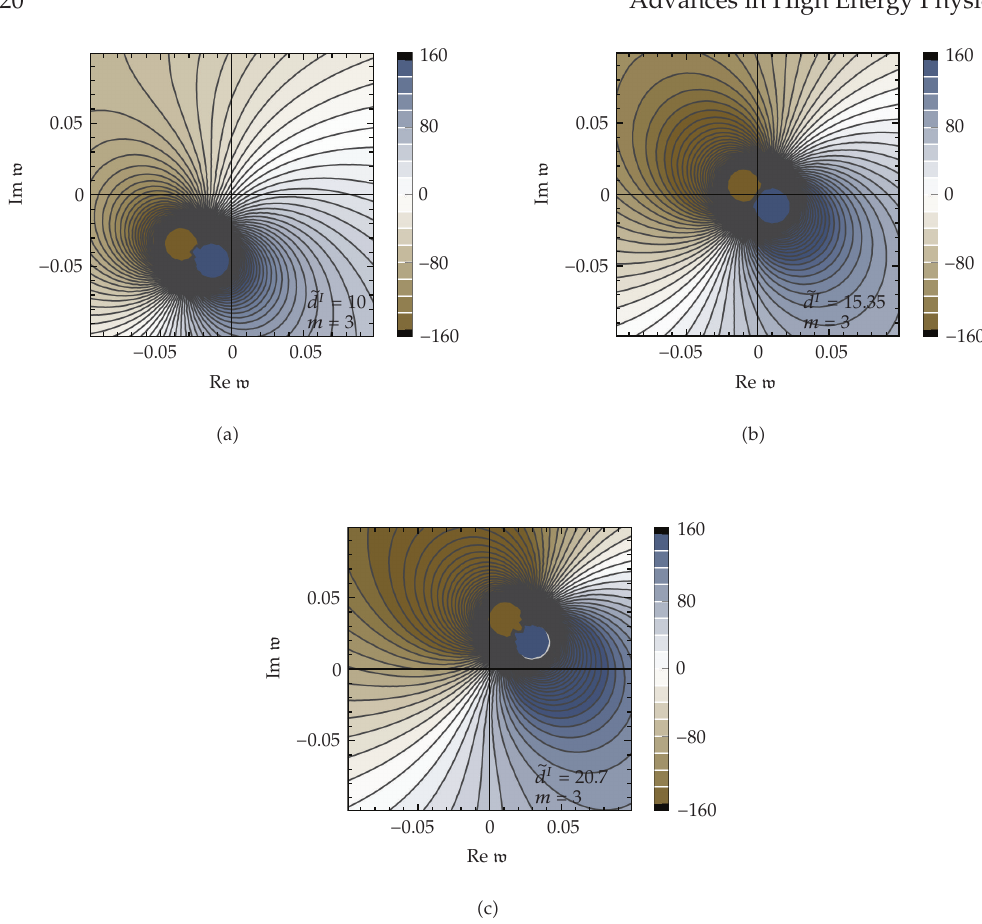
Figure 22: Contour plots of the spectral function for the mode Y around w (cid:5) 0 in the complex w -plane. The density increases from (cid:2) a (cid:3) at subcritical density to (cid:2) c (cid:3) at supercritical density. Here, the pole in the upper half plane introduces an